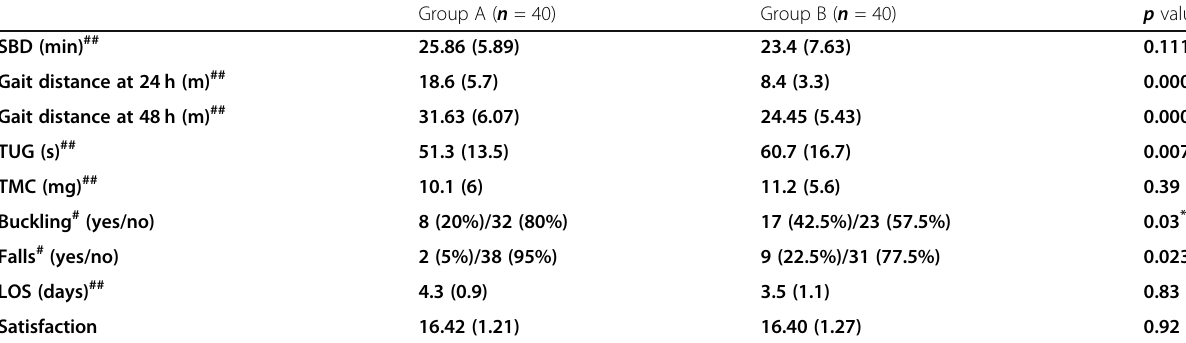
Table 3 Measured parameters